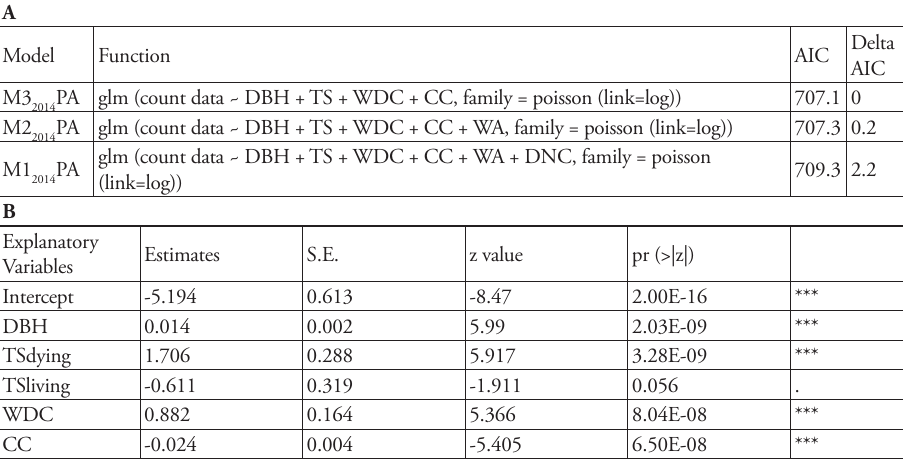
Table 5. Generalised Linear Models results. A) Explanatory variables selection and final best model for count data for R. alpina in PA in 2014. For each model are reported the function used to build the model, AIC value and Delta AIC for selecting the best model, B) Estimates and standard error (S.E.) of the